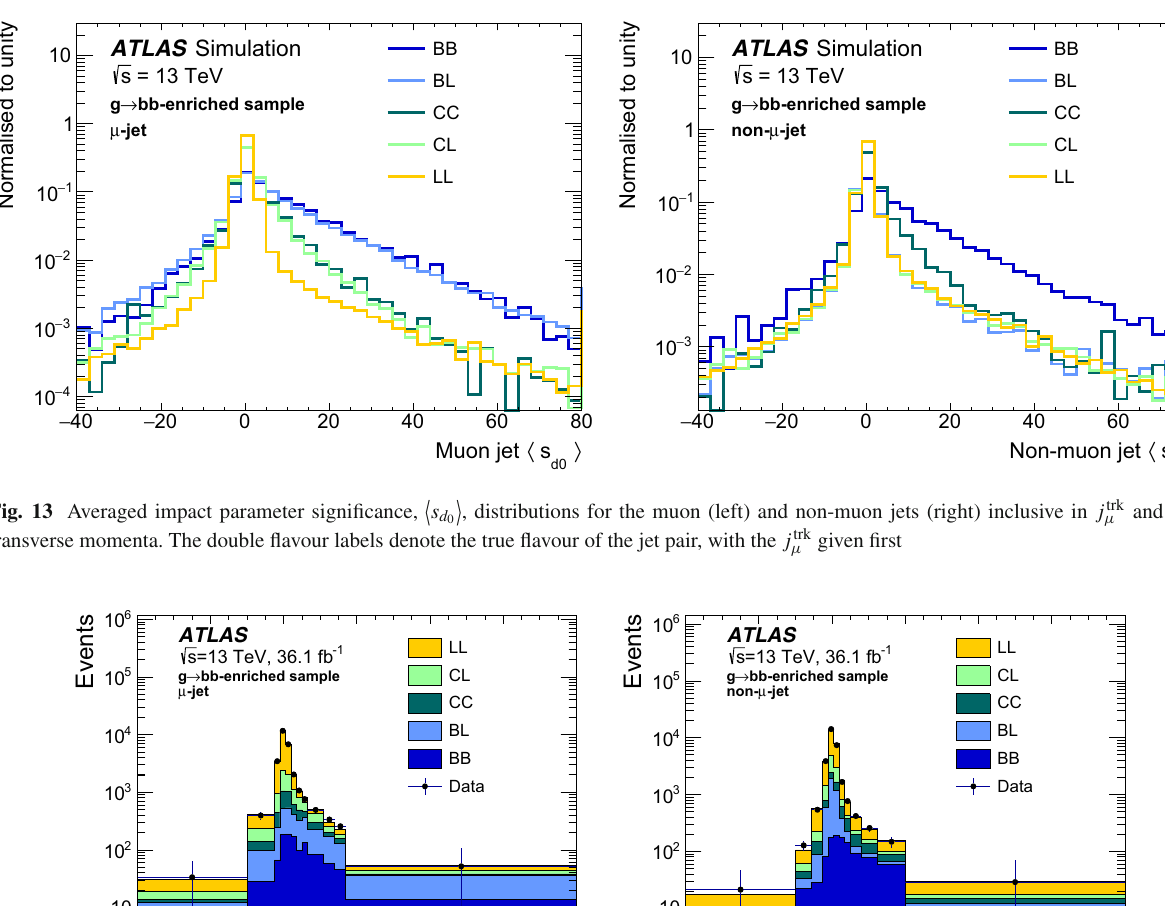
Fig. 14 Averaged impact parameter significance, j trk μ and j trk non- μ transverse